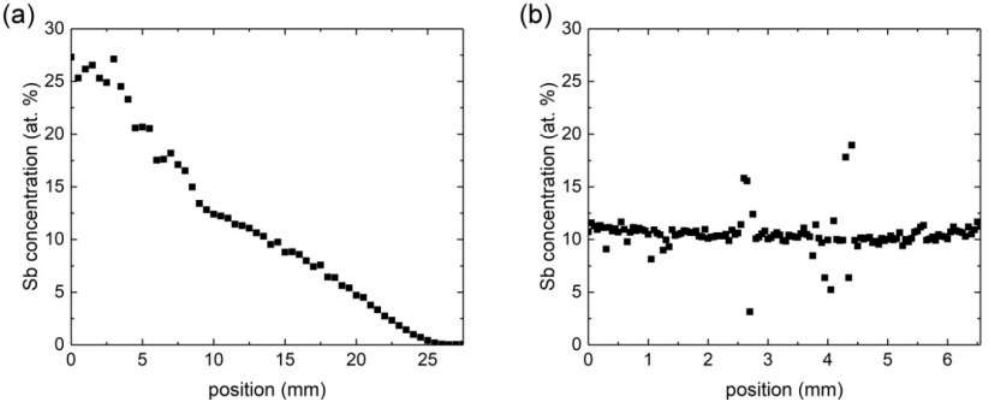
Figure 2. Electron probe microanalyzer (EPMA) line profiles of Sb concentrations obtained for the grown crystal. ( a ) EPMA line profile along the crystal growth direction; ( b ) EPMA line profile perpendicular to the crystal growth direction.